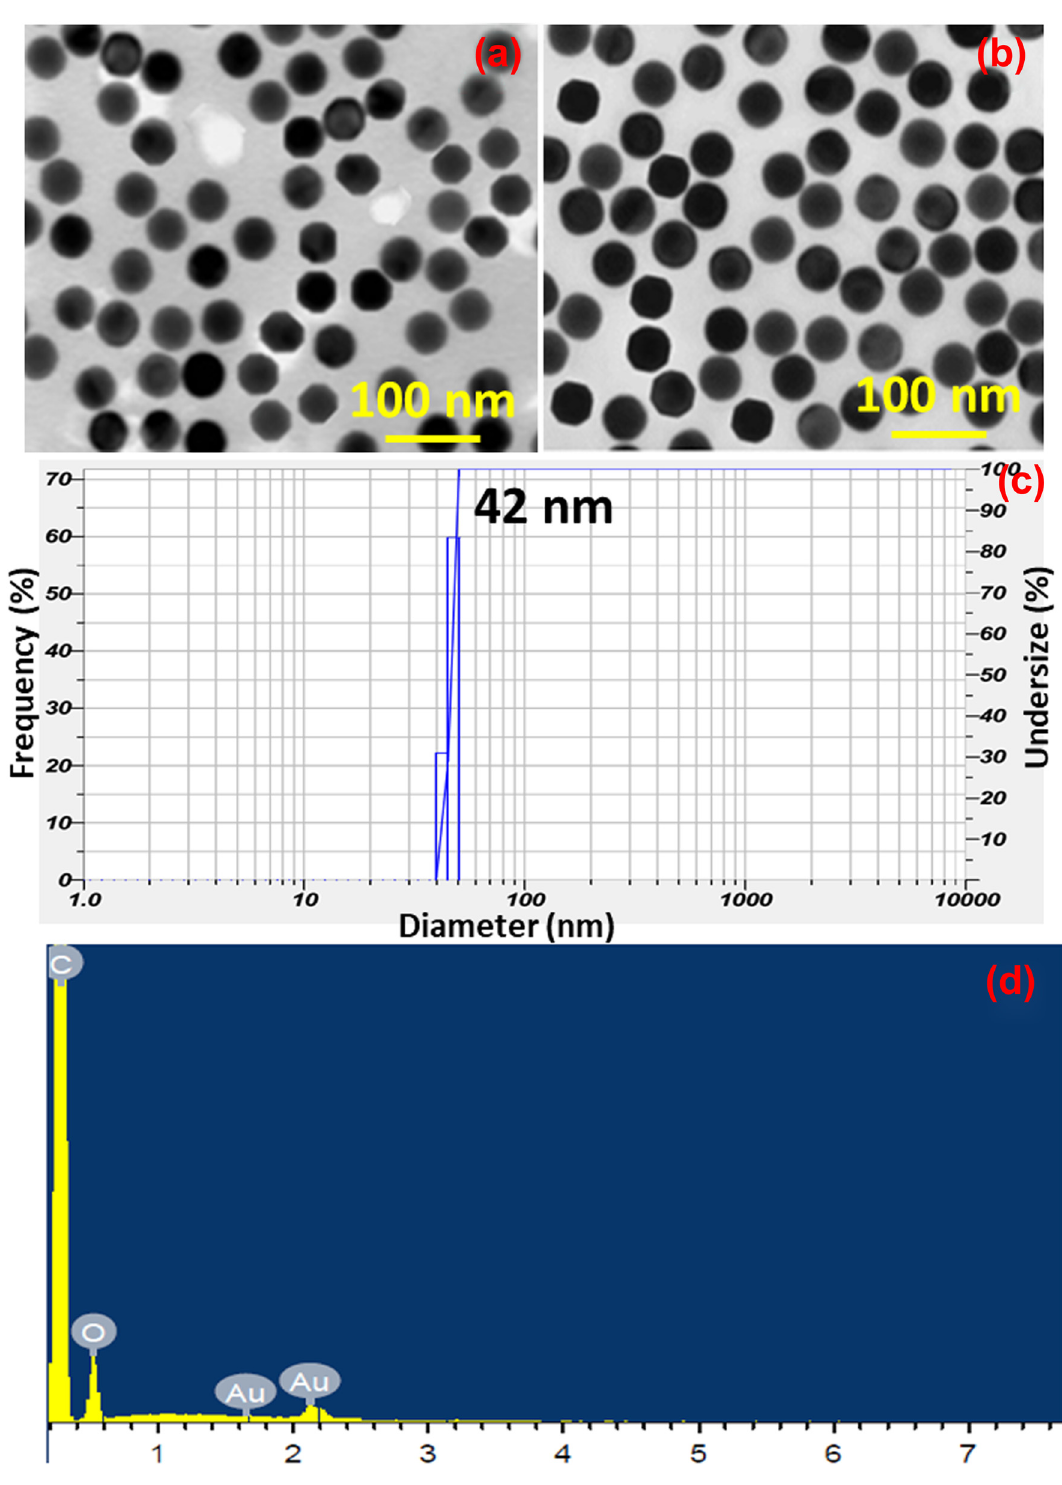
Figure 2: TEM images ( a and b ) ; DLS size distribution ( c ) and EDS spectrum ( d ) of